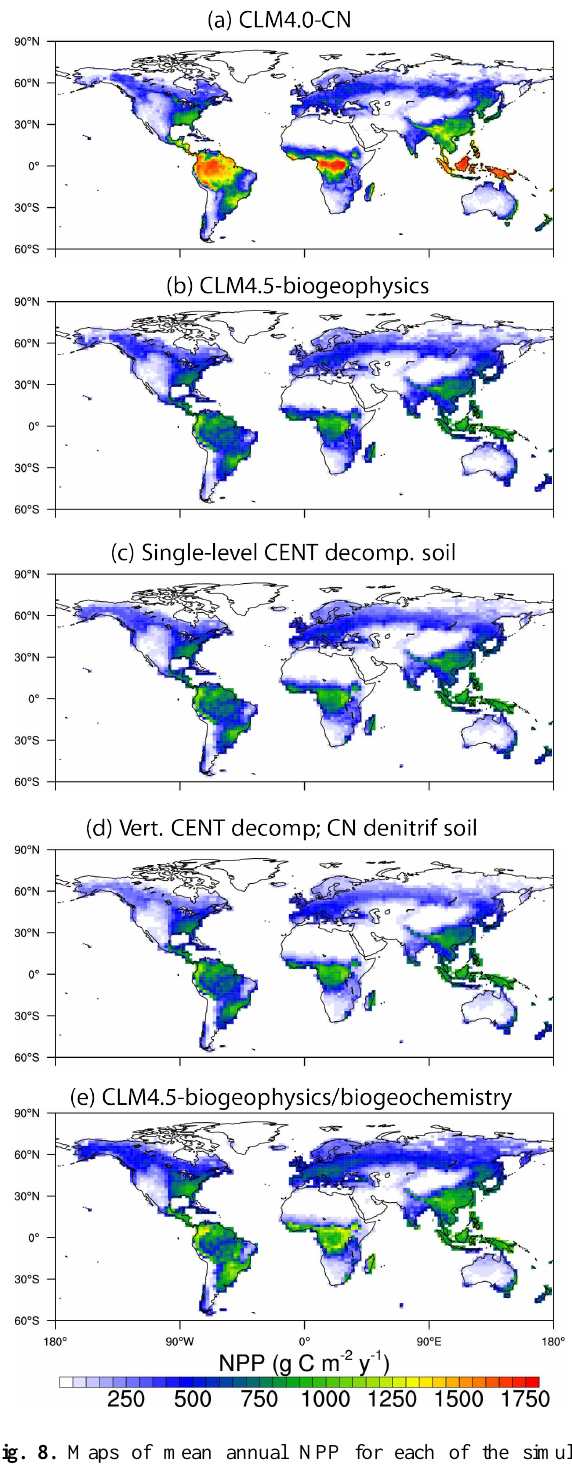
Fig. 8. Maps of mean annual NPP for each of the simula- tions. (a) CLM4.0-CN; (b) CLM4.5-biogeophysics; (c) single- level BGC, Century-based decomposition; (d) multi-level BGC, Century-based decomposition, CN denitrification; (e) multi-level BGC, Century-based decomposition and nitrification/denitrification